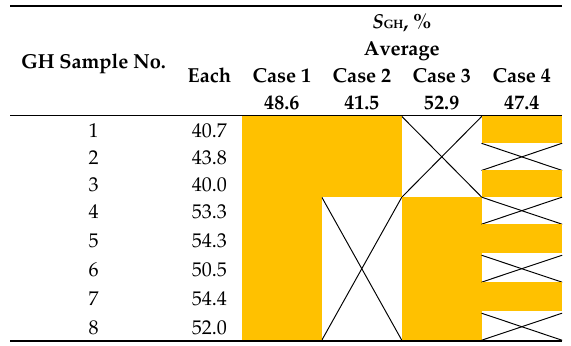
Table 2. Gas hydrate (GH) saturation and computerized tomography (CT) values in the “GH” stage for eight GH samples.